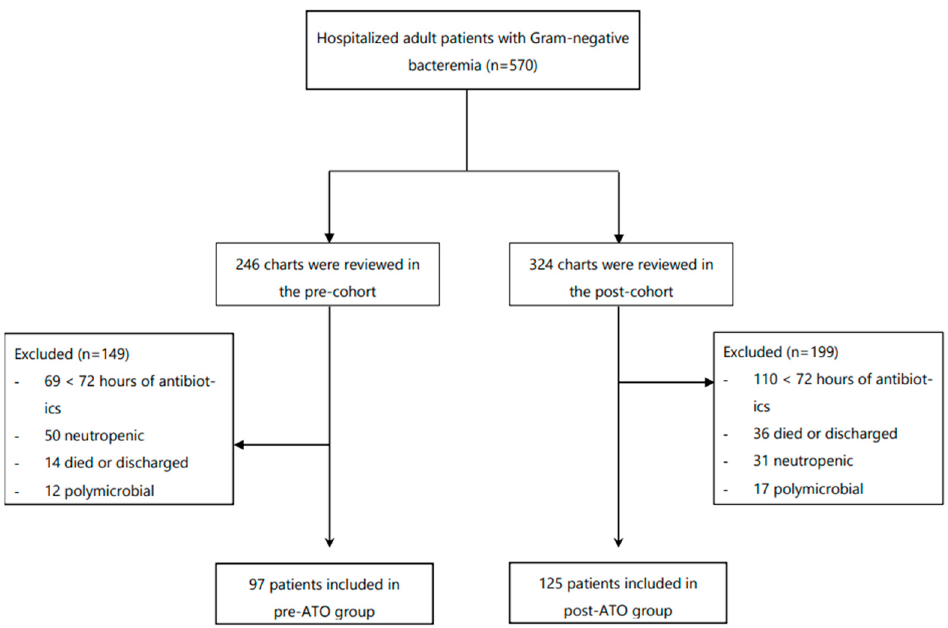
Figure 1. Study Figure 1. Study flowchart.